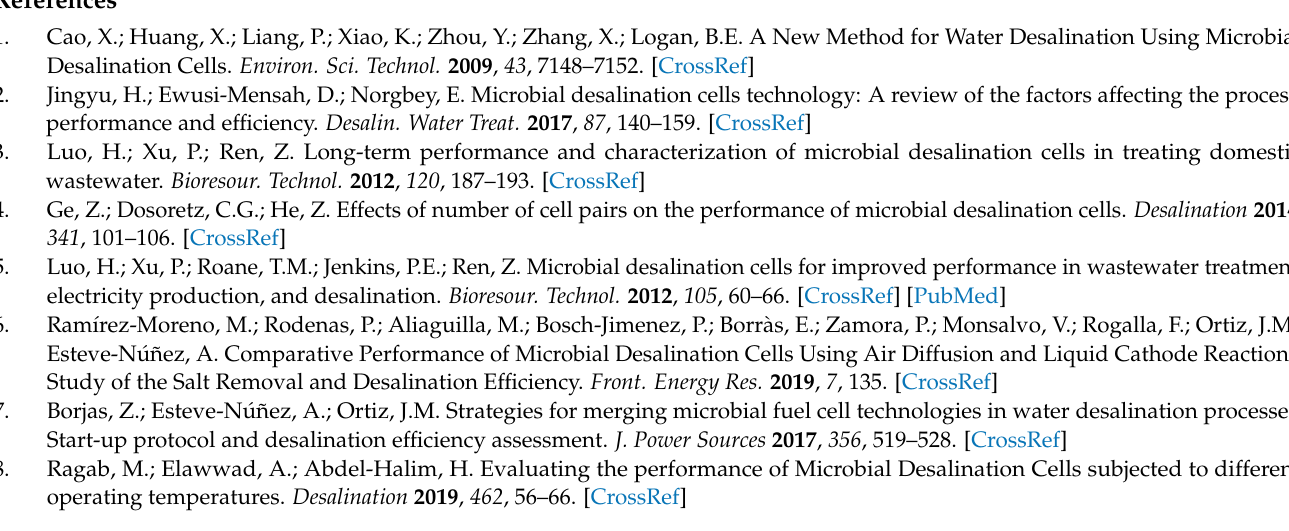
Figure S1: (A) Culture setup plan, (B) Culturing of algae culture for photobioreactor, (C) Newly inoculated BBM for culturing (right) and photobioreactor (left), (D) Microscopic view of Chlorella vulgaris ; Figure S2: Experimental phases; Figure S3: Abiotic test: (A) Electric conductivity in the anolyte, saline, and catholyte; (B) potential of a cell, anode electrode and cathode electrode against the Ag/AgCl reference